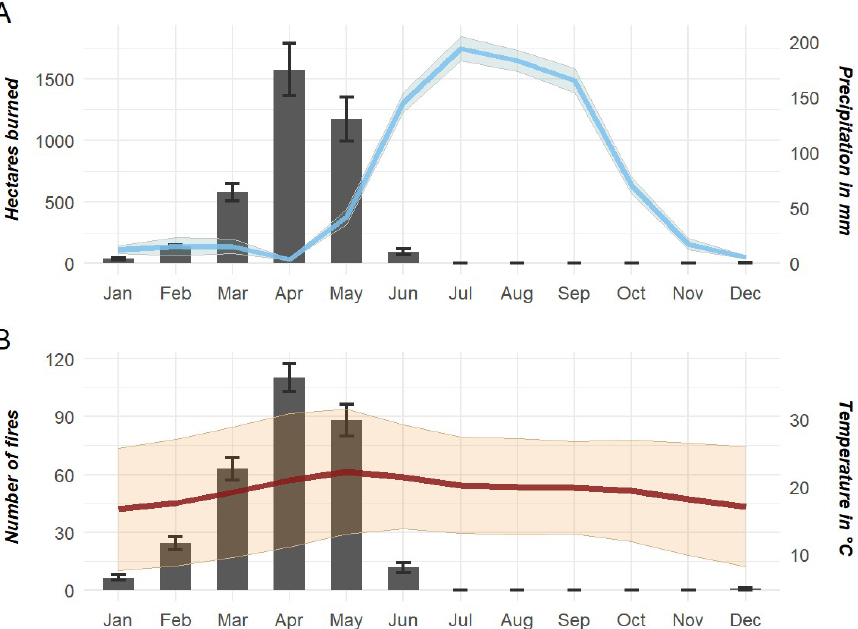
Figure 7. Average number of fires per month in the MAB from 2000 to 2017 throughout a mean year with ( A ) mean monthly precipitation and its standard error in a blue line and ribbon and ( B ) the mean monthly temperature in a red line and the maximum and minimum temperatures in the edges of a brownish ribbon.